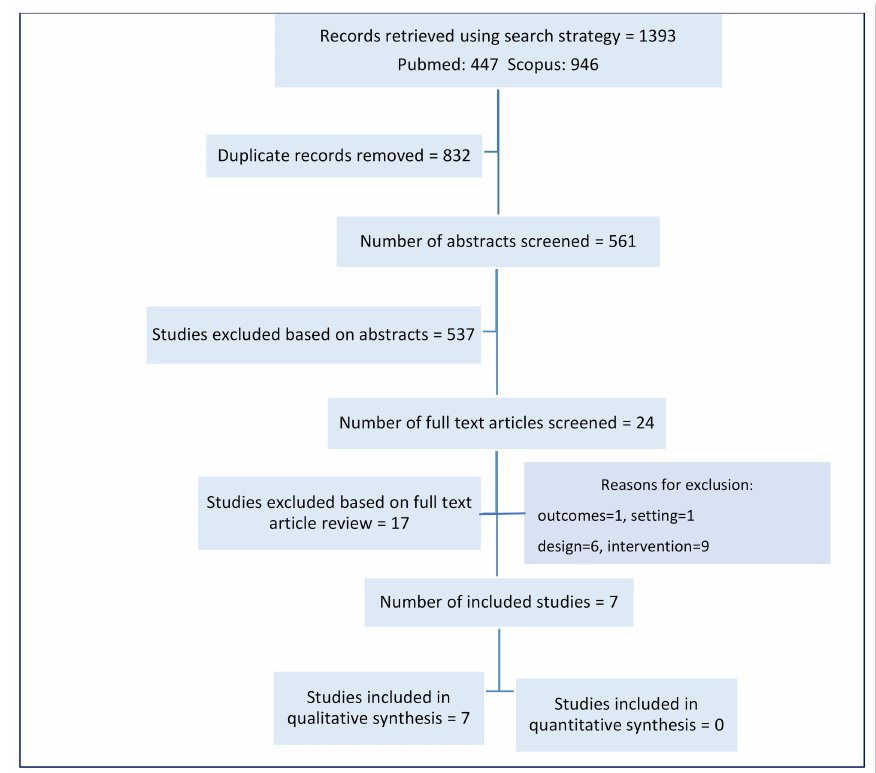
Figure 1. Study flow